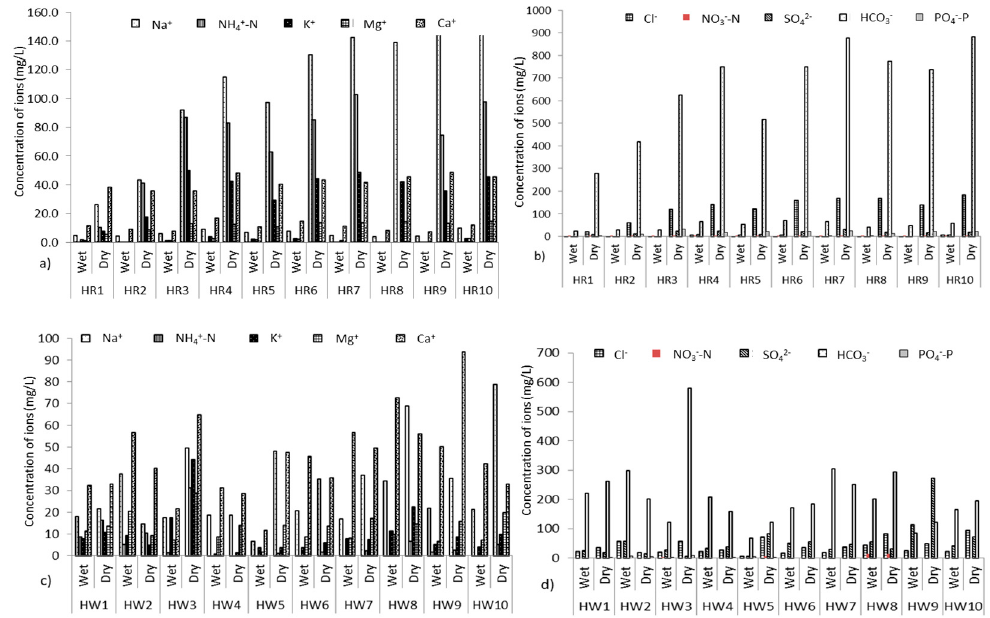
Figure 2. Bar diagram showing temporal and spatial variation of chemical parameters in river water ( a and b ) and groundwater ( c and d ). HR = Hanumante river water and HW = Hanumante groundwater.